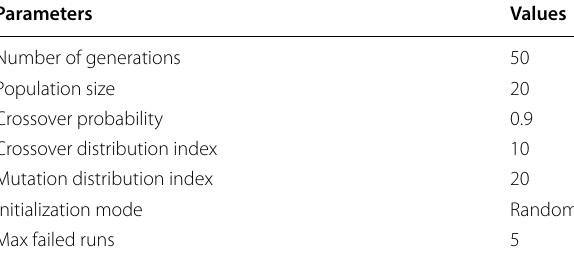
Table 2 Basic setting of the NSGA‑II